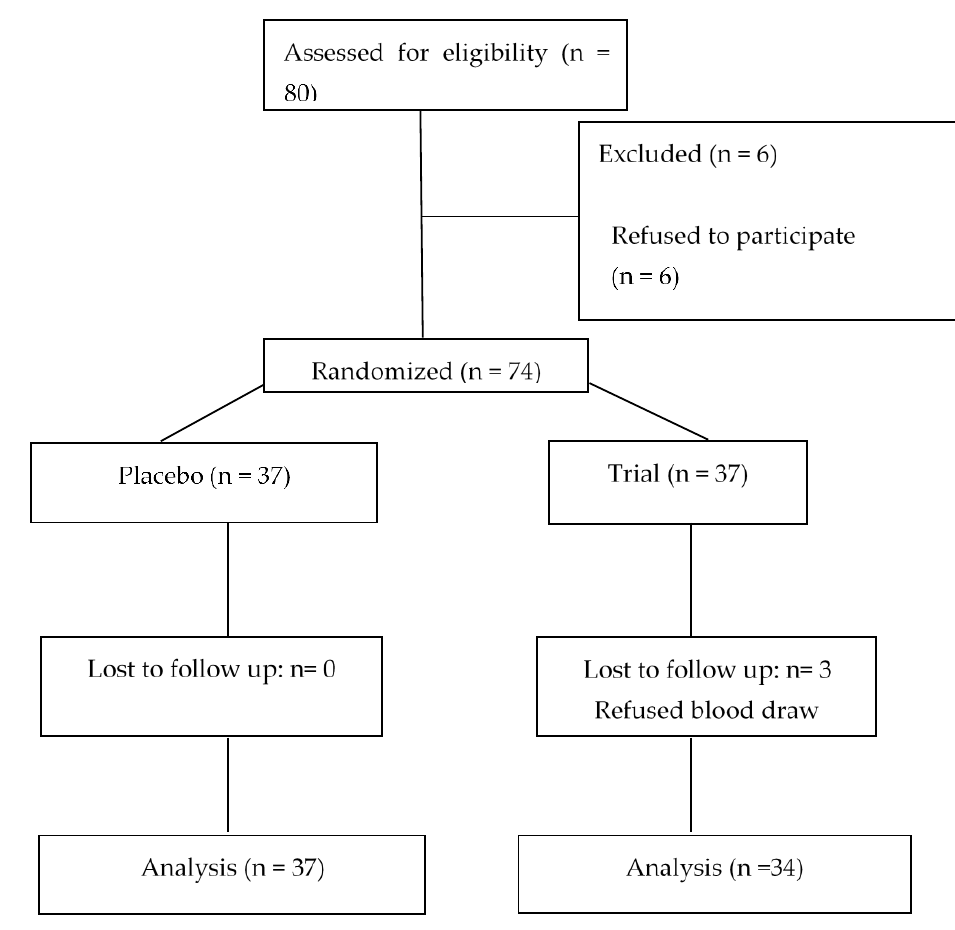
Figure 1. The study flow chart.